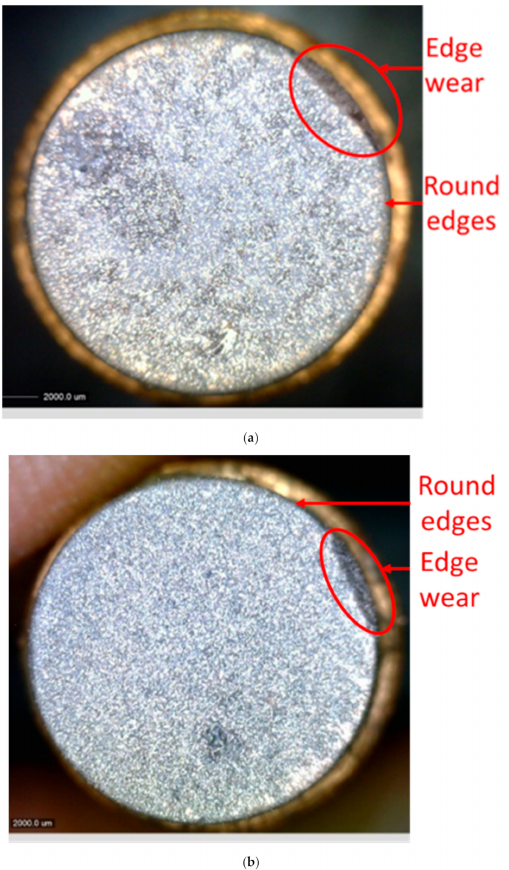
Figure 23. Variation in tool surface and profile with Toff ( a ) Toff = 30 µ s ( b ) Toff = 45 µ s; other process parameters Ip = 7 A, Vg = 60 V, Ton = 300 µ s, P = 16 kgf/cm 2